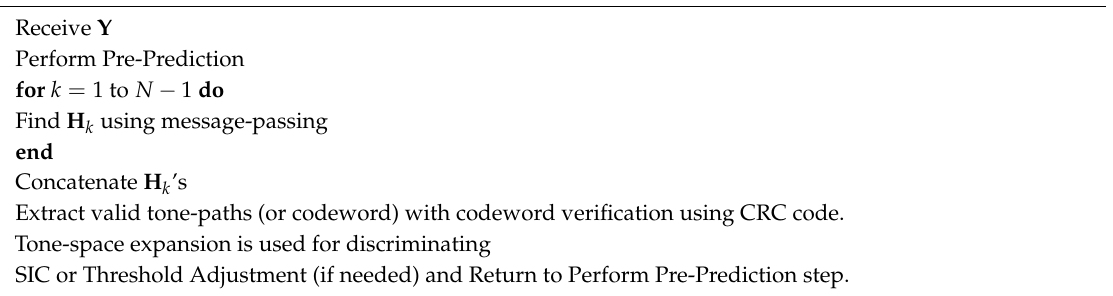
Algorithm 2 Procedure of Multi-User Detection of TTMMA